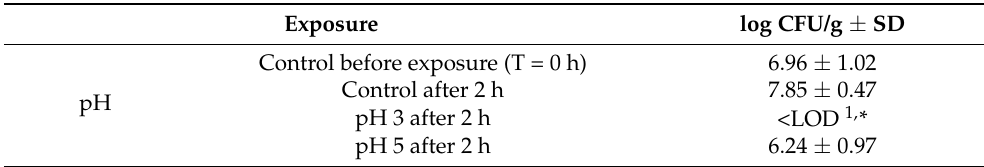
Table 3. Acid and bile tolerance of F. duncaniae DSM 17677 incorporated in the ISCR freeze-dried formulation containing inulin [5% ( m/v )]), sucrose [5% ( m/v )]), cysteine [0.2% ( m/v )]), and riboflavin (16.5 mM). Results were expressed as mean values in log CFU/g ± standard deviation